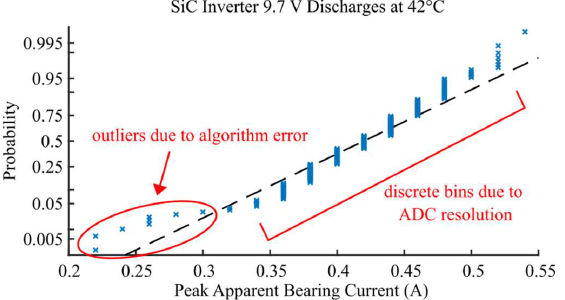
Figure 15. Probability plot of the raw SiC 9.7 V, 42 °C peak apparent bearing current